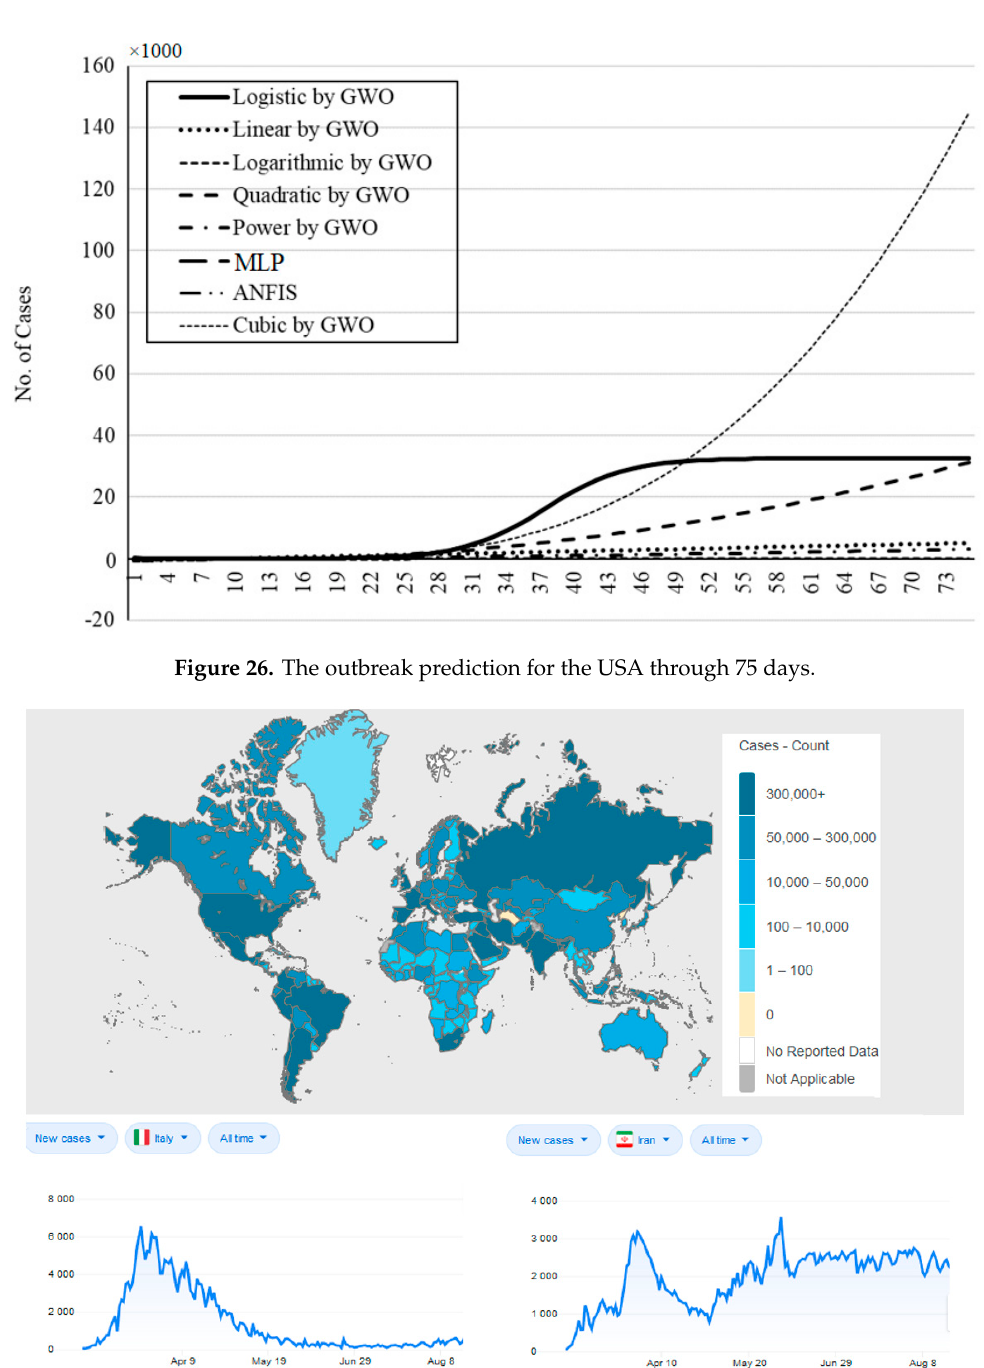
Table 18. The outbreak prediction for China through 150 days.